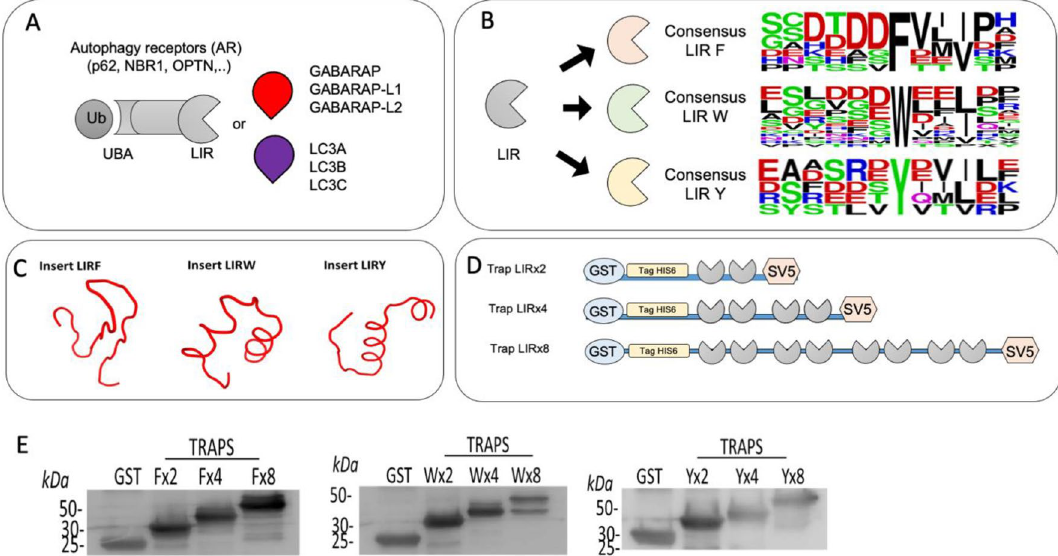
Figure 1. Strategy, design and production of LC3 traps. ( A ) Selective autophagy is driven by receptors that bind in one side ubiquitin chains through ubiquitin-binding domains (UBA) and in the other they interact with LC3/ GABARAP proteins using interacting regions (LIR). ( B ) The three major consensus sequence were analysed using Weblogo software (https:// weblo go. berke ley. edu) and named F, W or Y, according to the predominant hydrophobic amino-acid of these sequences. In the consensus, colours indicate chemical properties of amino acids: polar (G, S, T, Y, C, in green), neutral (Q, N, in purple), basic (K, R, H, in blue), acidic (D, E, in red), and hydrophobic (A, V, L, I, P, W, F, M, in black). ( C ) 3D structures of the peptides carrying two identical LIR consensus F, W and Y according to PEPFOLD software. Both LIR motifs face to each other in those 3D structures. ( D ) Representation of the molecular traps disposing 2, 4, and 8 LIR sequences in tandem. GST, His6 and SV5 tags are located at the N-terminus and C terminus of each construct. ( E ) Recombinant proteins produced in E.coli . Western blot analysis using anti-GST antibody of the distinct LC3-traps and GST control. Cleaved products of LC3-traps generated during the induction and purification procedure can be observed, in particular for traps containing 8 LIR